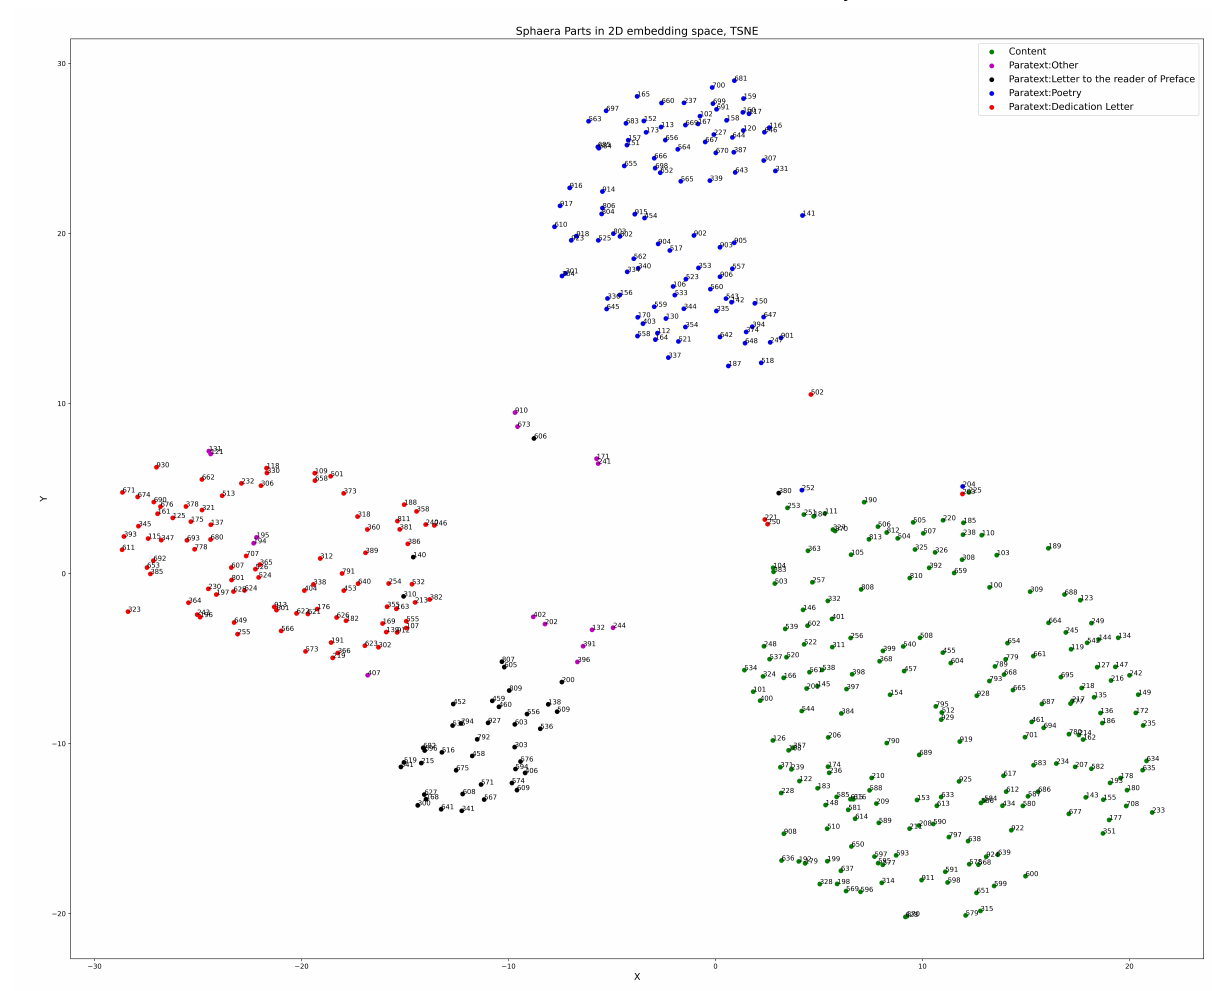
Figure 7. The t-SNE representation of the 450 part entities generated from an incomplete Sphaera knowledge